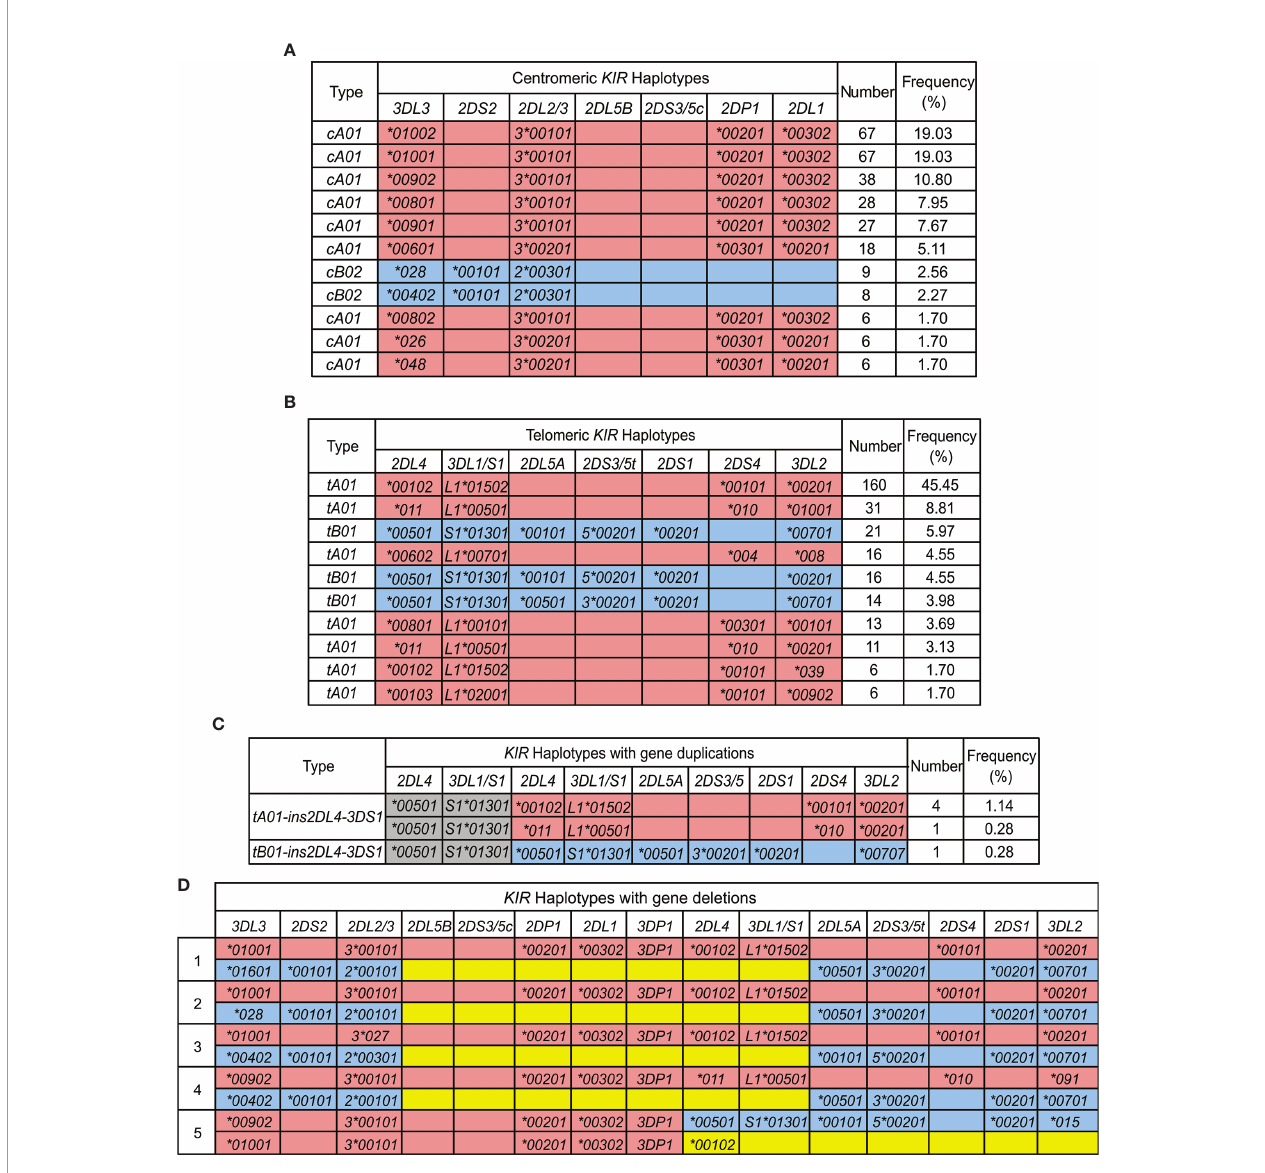
FIGURE 5 | KIR haplotypes identi fi ed in 176 Zhejiang Han. (A, B) . Shown are the ten most frequent centromeric and telomeric haplotypes and their frequencies observed in Zhejiang Han. (C) Shown are the extended telomeric haplotypes observed in Zhejiang Han. (D) Shown are the two complete haplotypes for each of the fi ve individuals who exhibit contracted KIR haplotypes. KIR-A haplotype are shaded red and KIR-B haplotypes are blue. Gray indicates insertion. Yellow indicates deletion. Blank boxes indicate gene absence. The frequencies of haplotypes are shown at the right. * standard WHO nomenclature for KIR